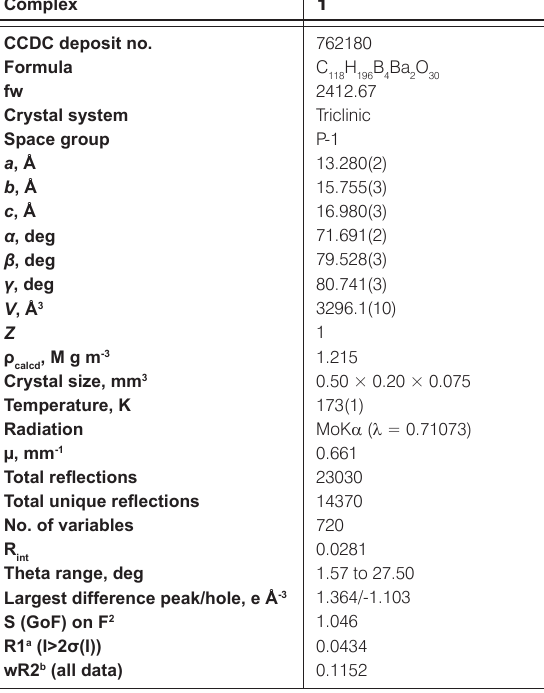
Table 1. Crystallographic data collection parameters for 1